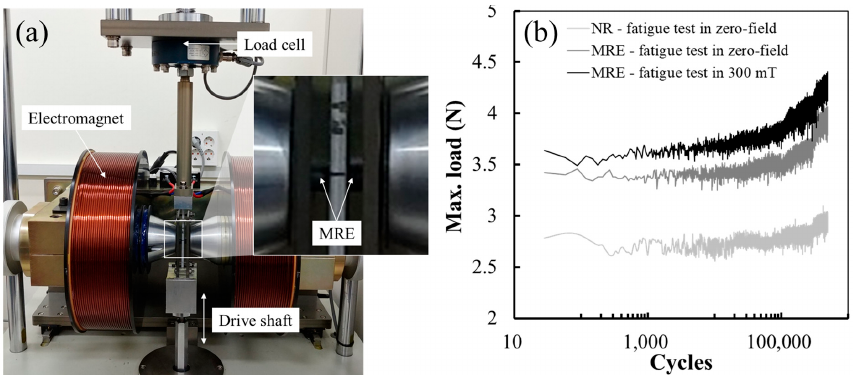
Figure 1. ( a ) Photos of the modified electromechanical fatigue system equipped with an electromagnet. ( b ) Maximum recorded load during cyclic shear fatigue of the NR and anisotropic MRE samples.